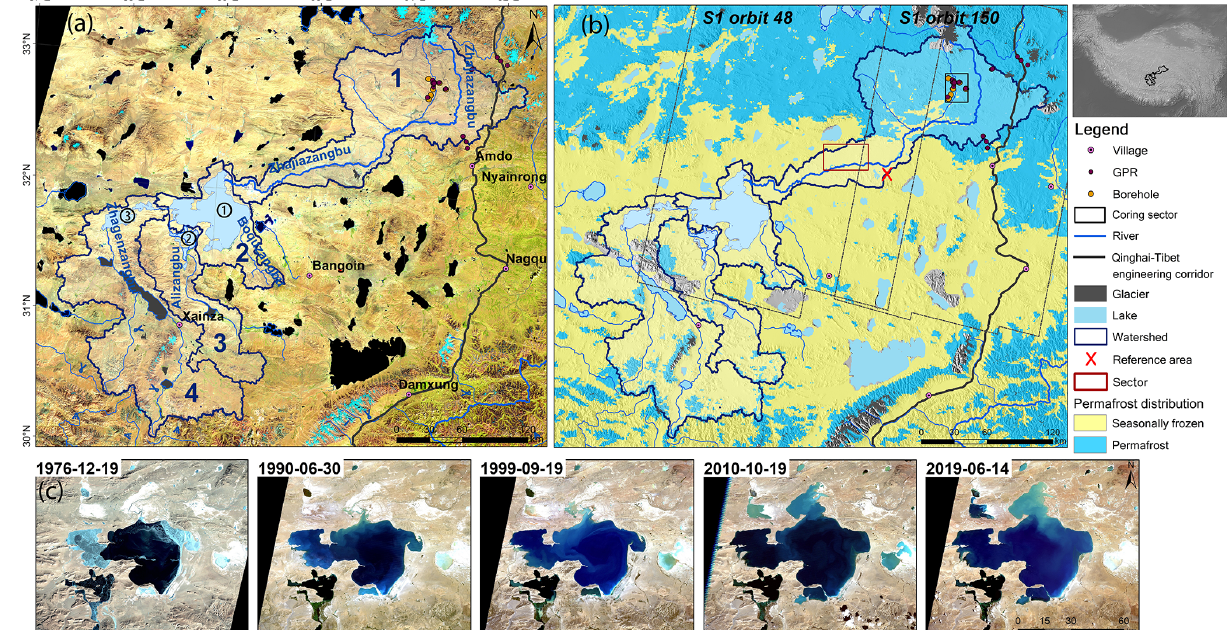
Figure 1. Study area. The base map in (a) is a Landsat 8 image acquired in October 2020 (red: SWIR1, green: NIR, blue: red). The base map in (b) is a permafrost map (Zou et al., 2017); the hillshade is calculated using a 1arcsec SRTM DEM with the Sentinel-1 incidence angle and azimuth angle. The dashed grey lines delineate two tracks of Sentinel-1 used in this study. The red cross marks the position of our InSAR reference point. The locations of the GPR surveys and boreholes are shown with dots. Panel (c) shows the lake areas from 1976 to 2019 on Landsat optical images (date format yyyy-mm-dd). Table 1. Characteristics of the Selin Co basin. The glacier coverage information is from the second Chinese glacier inventory (Guo et al., 2015; S. Liu et al., 2012), and the permafrost coverage information is from Zou et al. (2017). Basin Area Average Glacier coverage Permafrost coverage (km 2 ) elevation Area Percentage of Percentage of the Area Percentage of Percentage of the (ma.s.l.) (km 2 ) subbasin area (%) entire basin area (%) (km 2 ) subbasin area (%) entire basin area